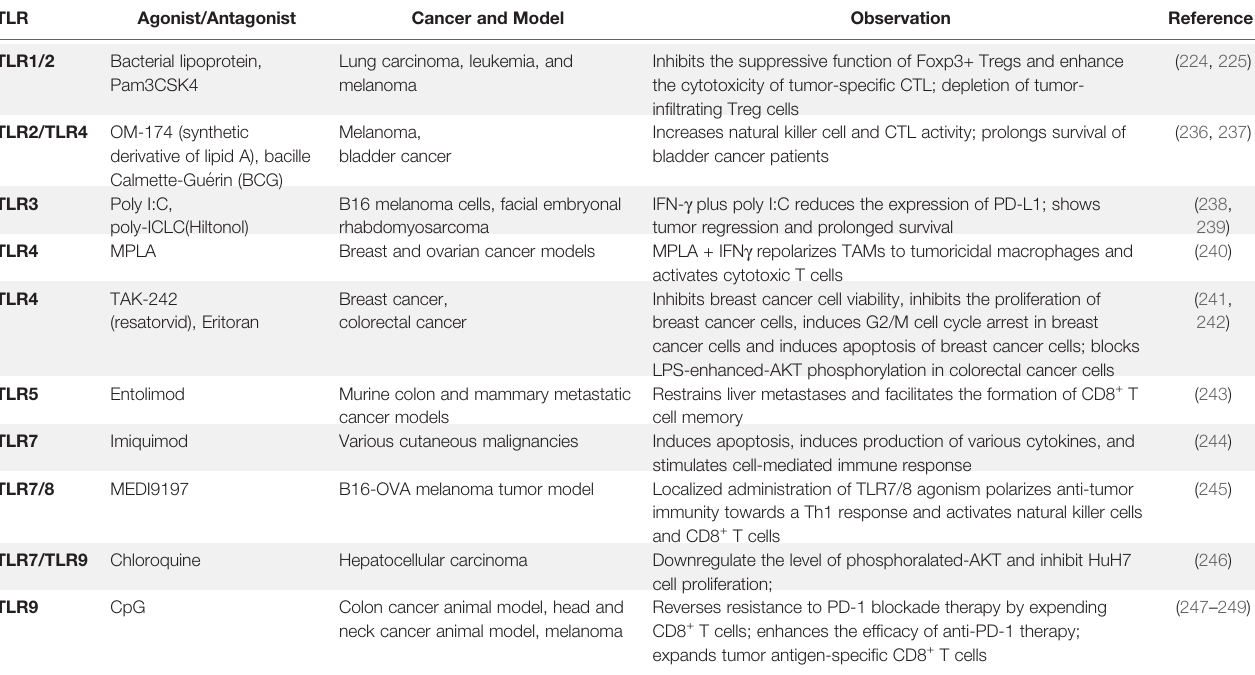
TABLE 1 | TLR agonists, antagonists and cancer.